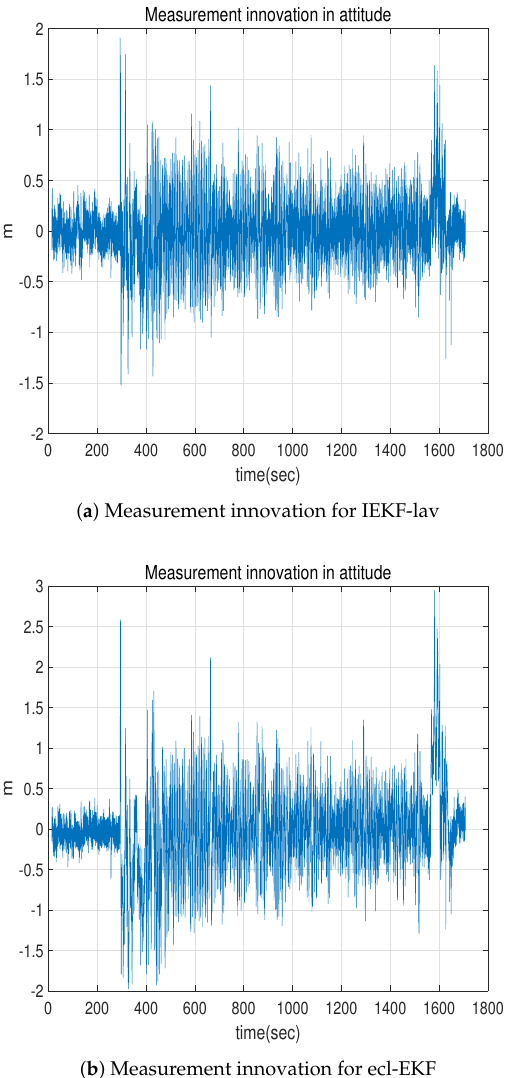
Figure 9. Comparison of measurement innovation for altitude ( z -coordinate